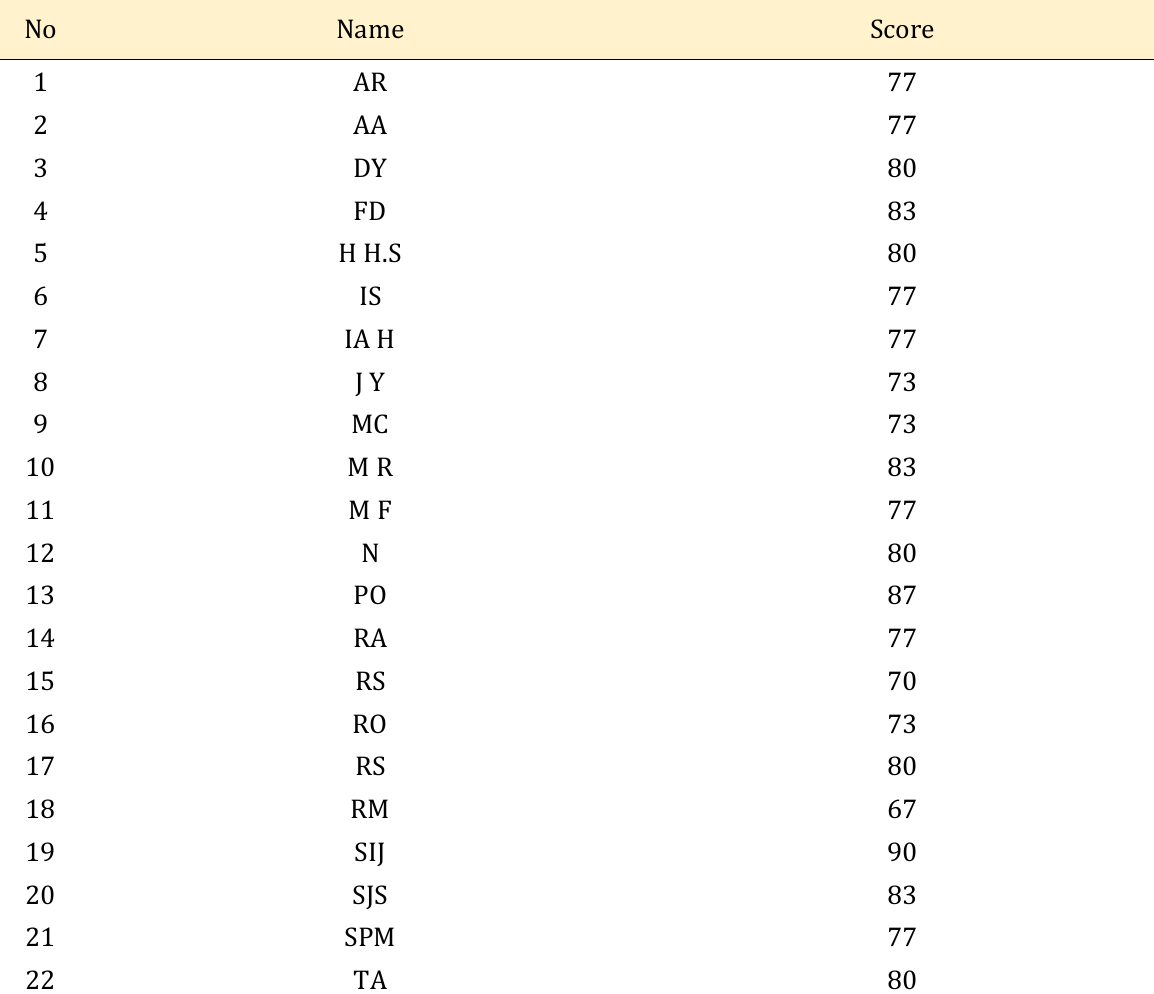
Table 3: The Result of the X AKL Students' daily scores in speaking X AKL X